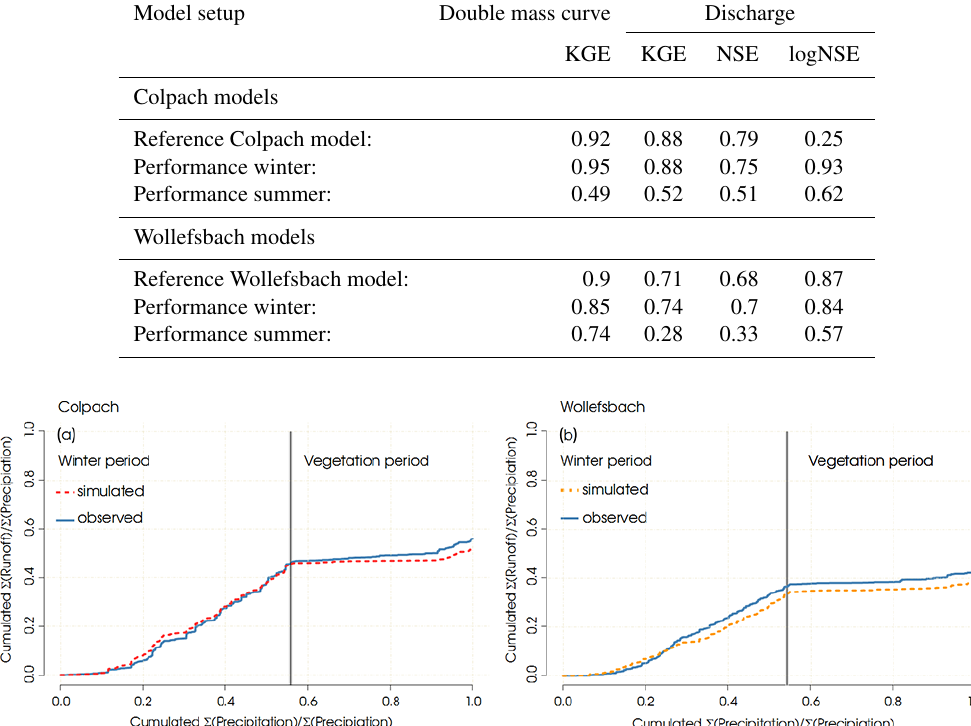
Figure 8. Simulated and observed normalized double mass curves of (a) the Colpach catchment and (b) the Wollefsbach catchment. The double mass curves are separated into a winter period and a vegetation period following Menzel et al.